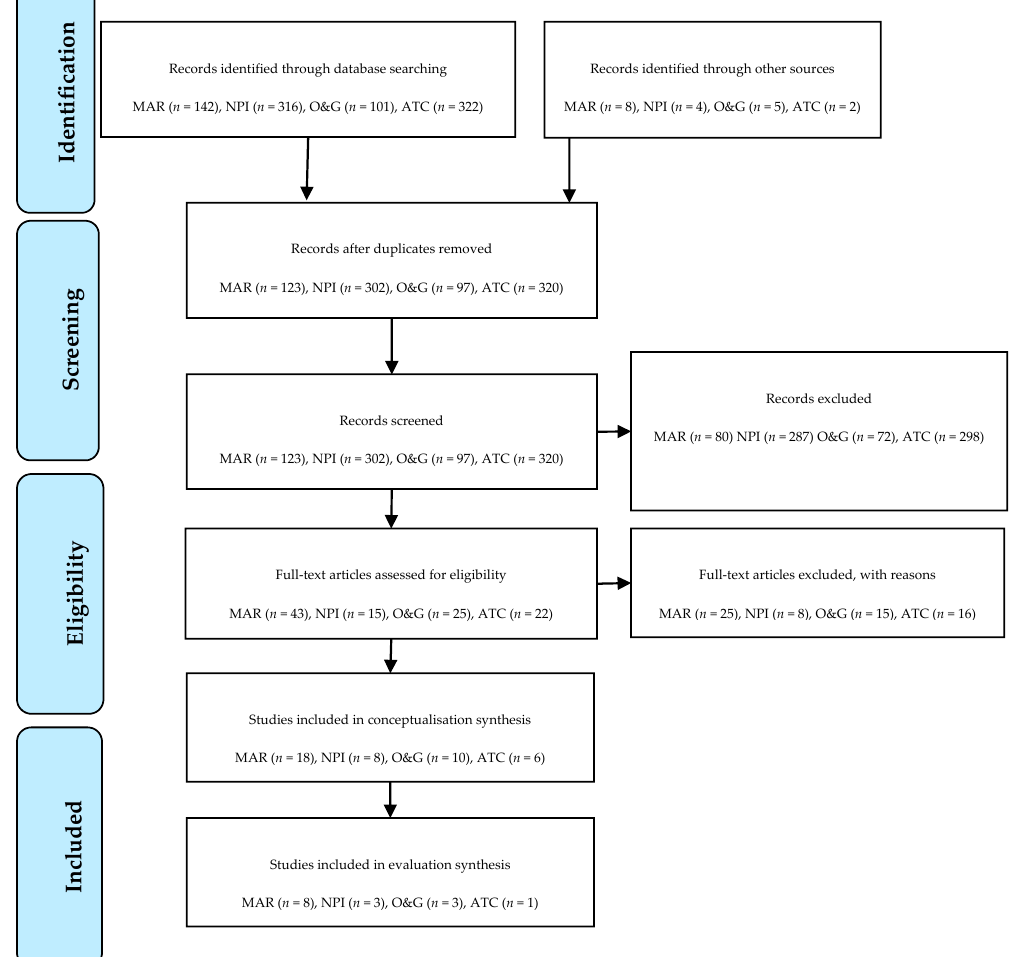
Figure 1. PRISMA flow diagram.